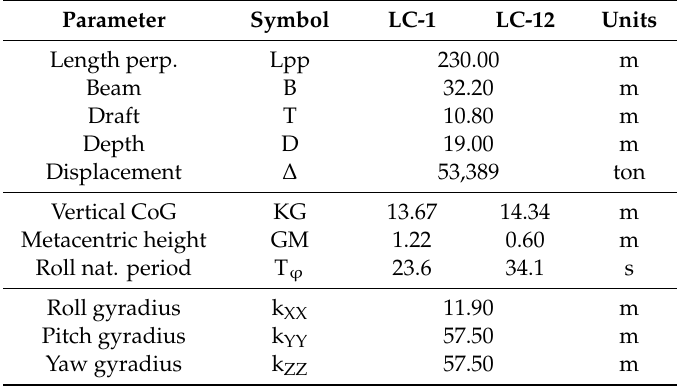
Table 1. Main dimensions and loading conditions of the KCS for the parametric roll experiments. LC-1 has been used for experiments in head seas, LC-2 for experiments in following